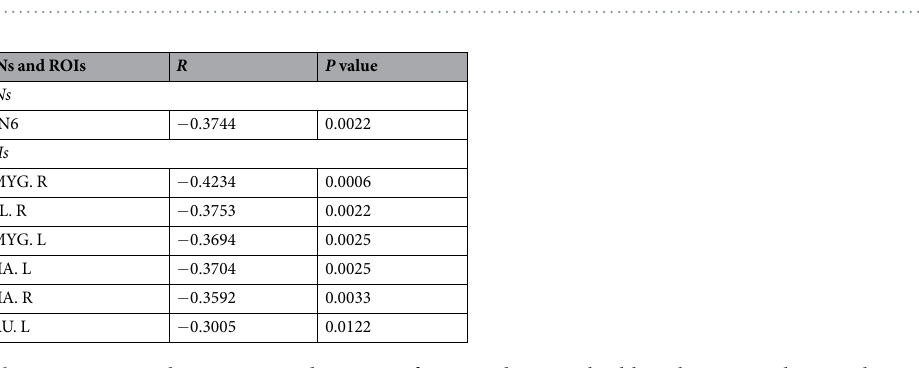
Figure 3. The mean SampEn of each ROI and each RSN across all healthy subjects. The mean SampEn of each ROI across all healthy subjects ( a ). The color bar indicates the values of SampEn. The mean SampEn of each RSN across all healthy subjects is depicted in descending order ( b ). The error bars represent SD. RSN1, the default mode network; RSN 2, the attention network; RSN 3, the visual recognition network; RSN 4, the auditory network; RSN 5, the sensorimotor network; RSN6, the subcortical network.